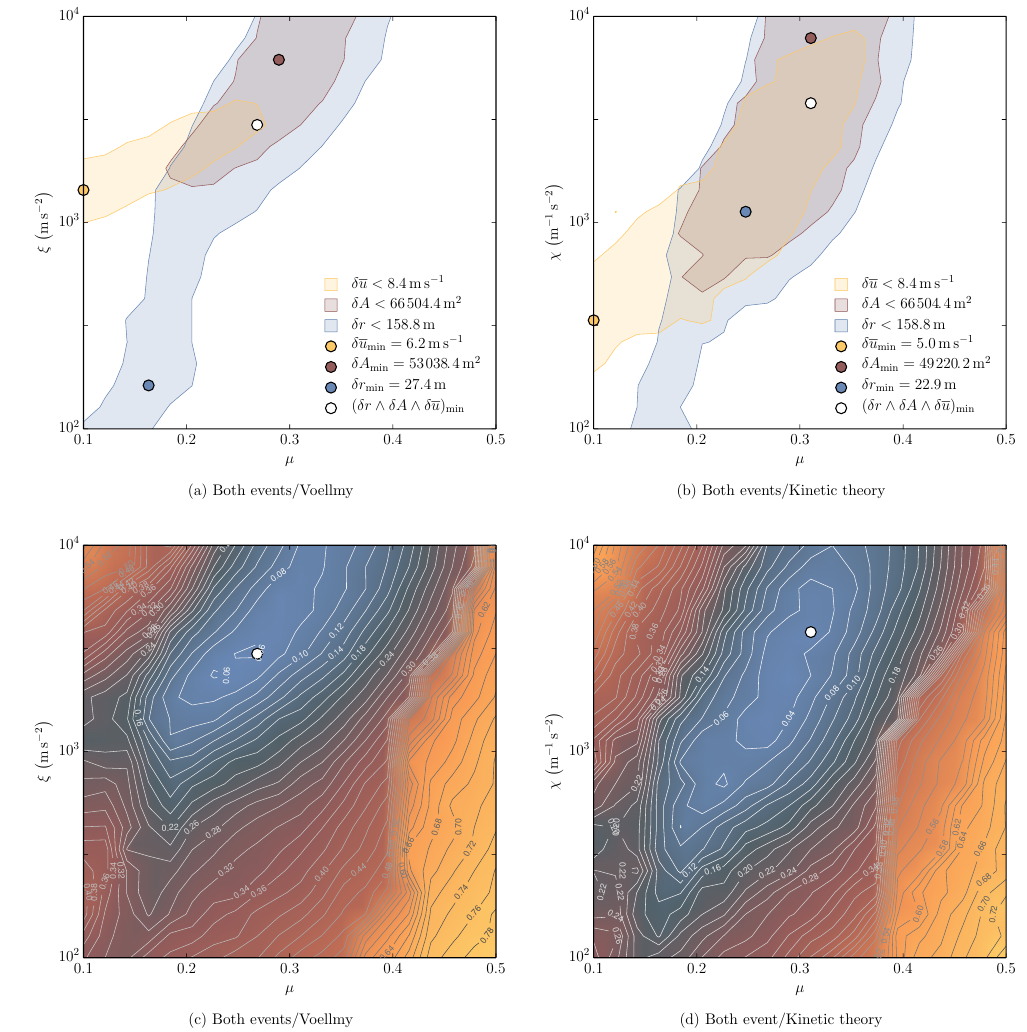
Figure 16. (a, b) Areas in the parameter space with relatively small residuals (less than 10% on the normalized scale) for the runout length (blue), the affected area (red) and the velocity (yellow) for both events combined. The circle in the respective color marks the simulation with the smallest residual δX min (optimization to a single variable for both events, type c). The white circle shows the minimal combined residual of runout, affected area and velocity (optimization, type d). (c, d) The combined residual in the parameter space. This surface has a clearly visible local minimum within the physical relevant area. Their position matches with the white circles in the graphs above. The minimal residual is in both cases located within the intersecting